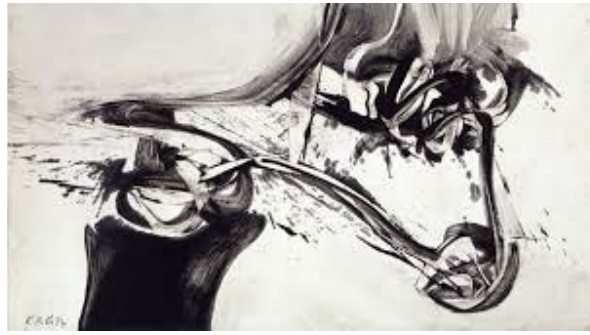
Figure 13 | K.O. Götz, Trefang,